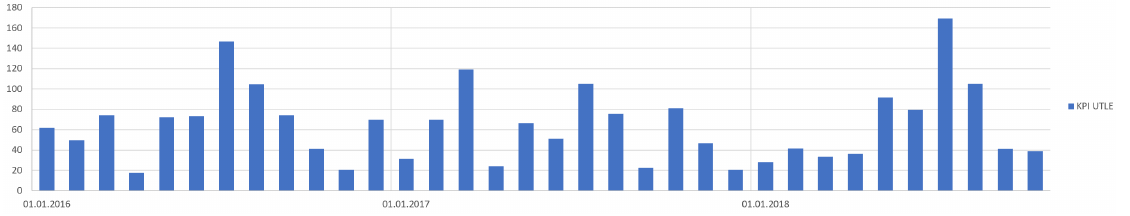
Figure 12. Unit trip load efficiency (UTLE) (%) values calculated for the same period as presented in Figure